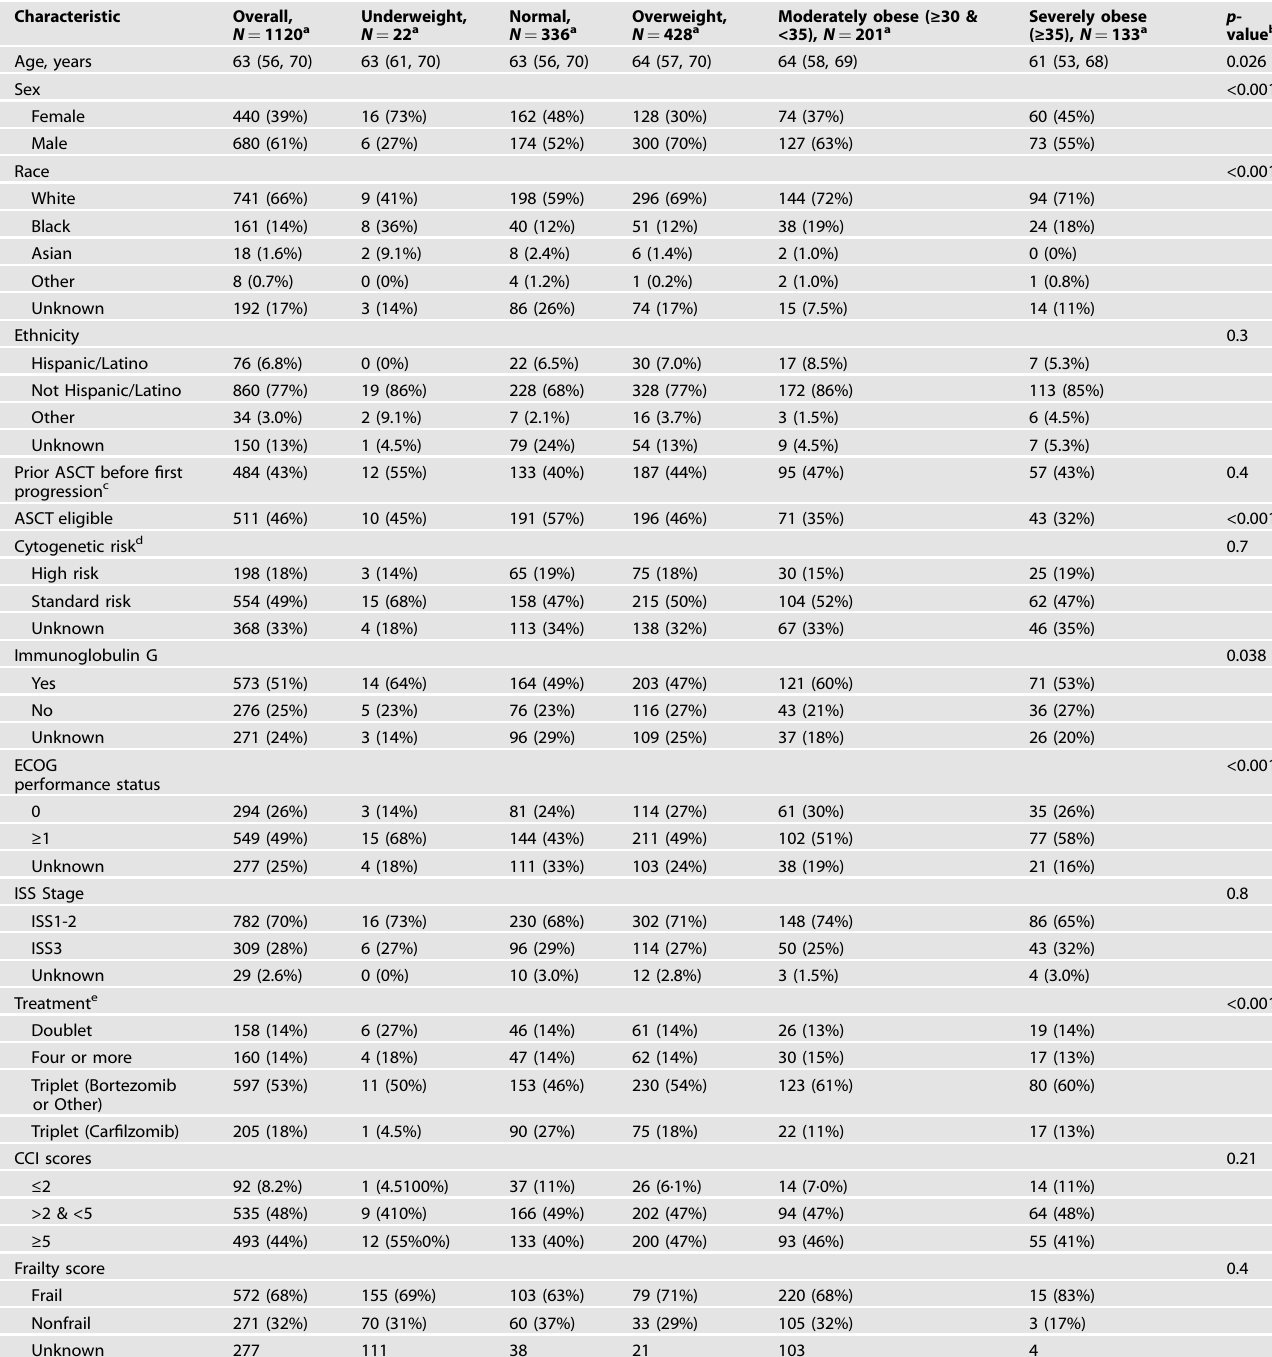
Table 1. Select baseline demographics according to category of BMI at diagnosis among 1120 newly diagnosed MM patients in the multiple myeloma research foundation CoMMpass